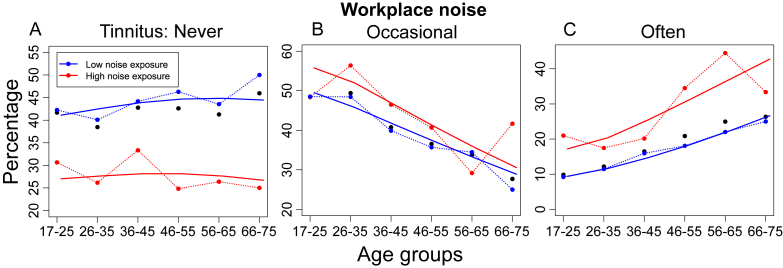
Workplace noise exposure and tinnitus prevalence. Details as per Fig. 3. Model: Tinnitus ∼ Age + Noise.